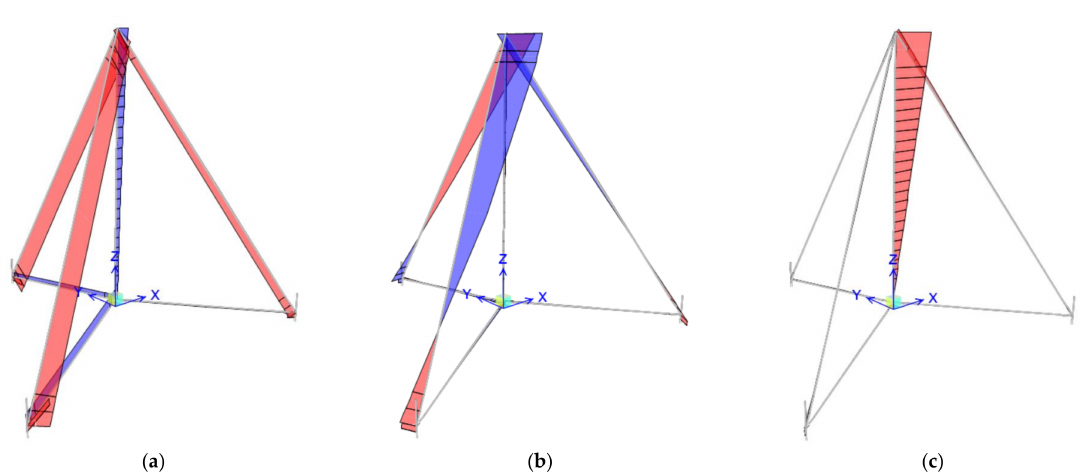
Figure 15. Axial force and bending moment diagrams for loading scenario 1: ( a ) axial forces, ( b ) bending moments M 2 and ( c ) bending moments M 3